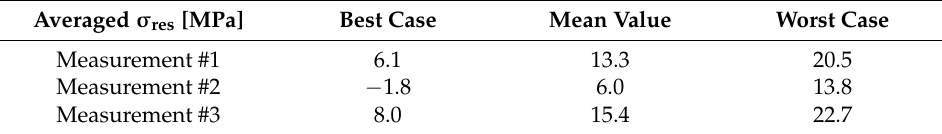
Table 2. Averaged residual stresses from XRD measurements in three different